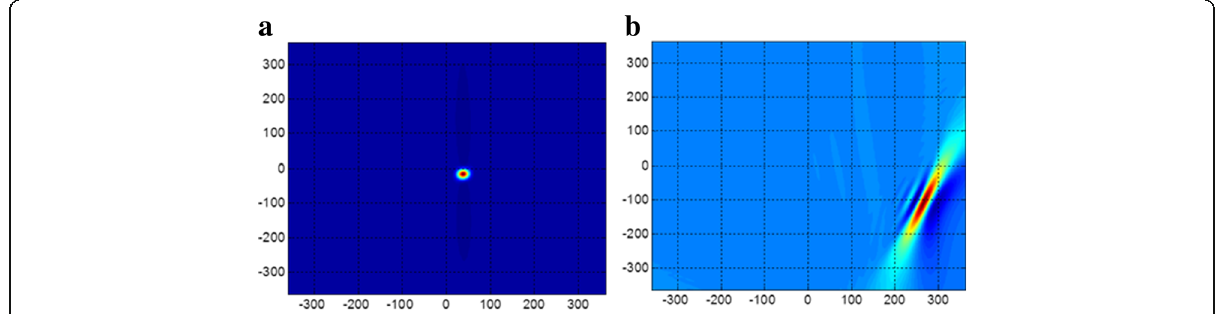
Fig. 4 IRT results of echo signals. a The non-aliasing situation at 10 GHz. b The aliasing situation at 0.33